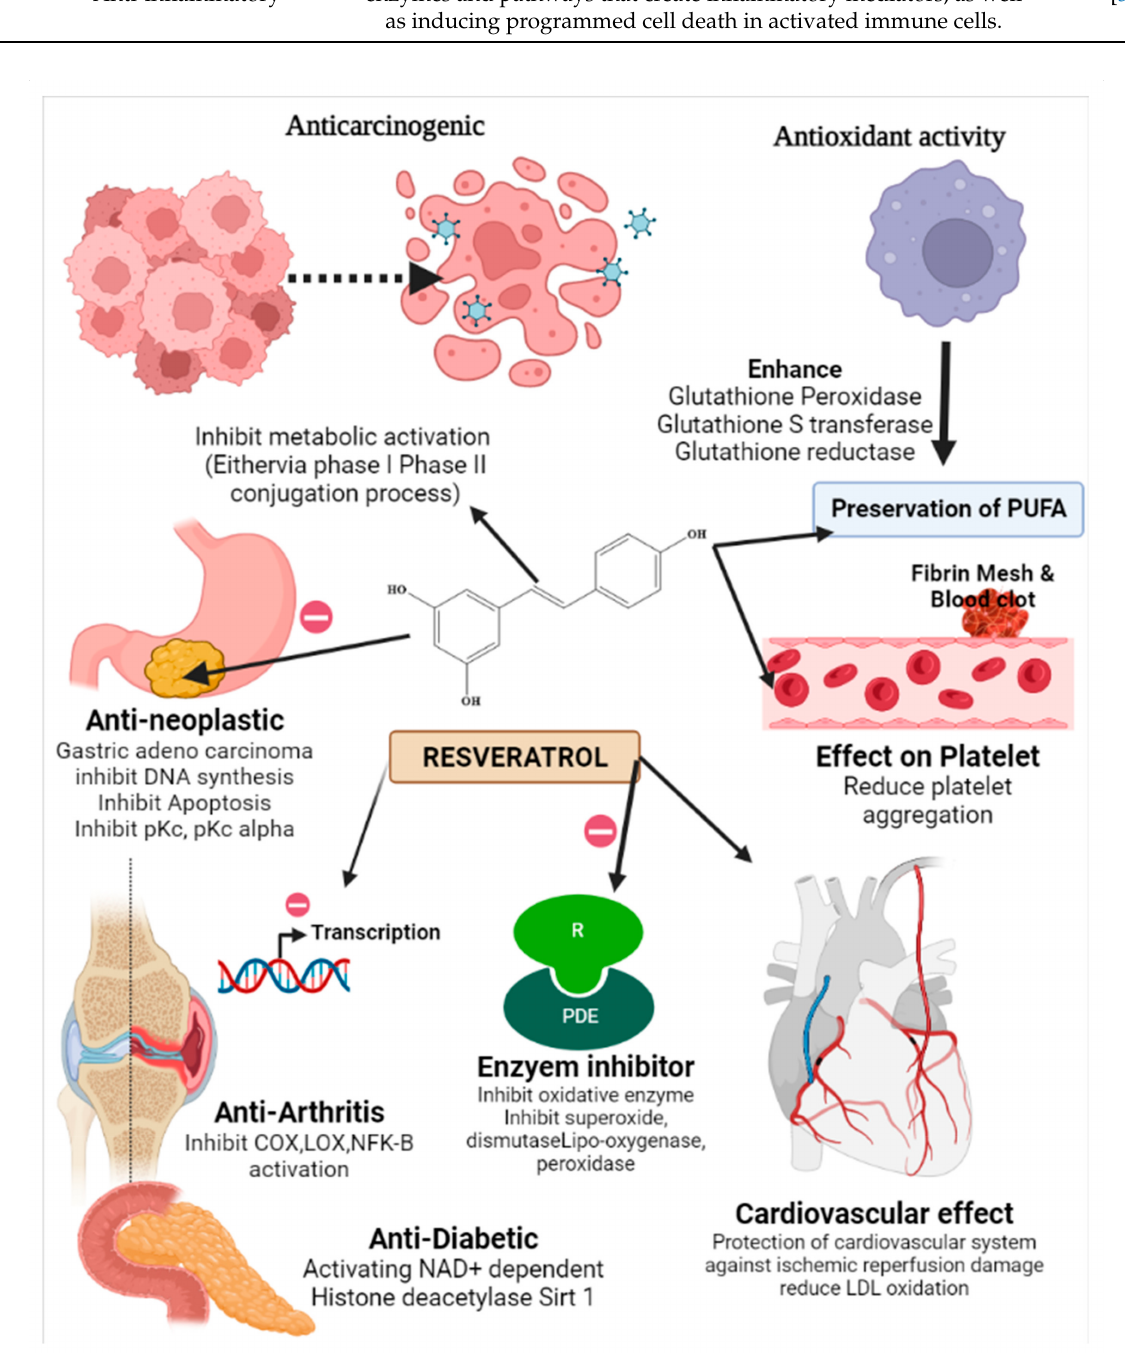
Figure 2. shows the mechanism of action of